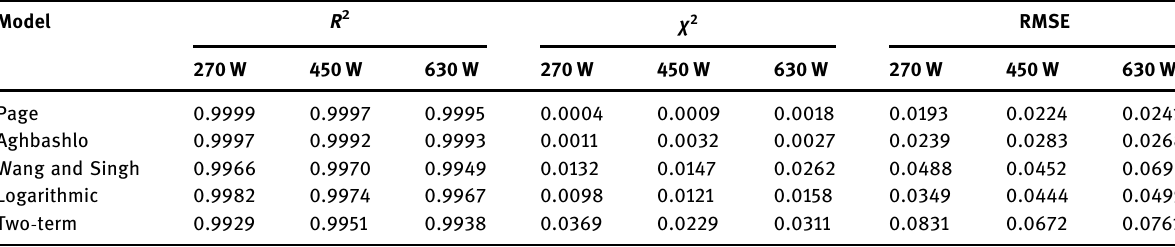
Table 3: Statistical parameters characterizing the modelling of pomegranate arils ’ drying in MW dryer